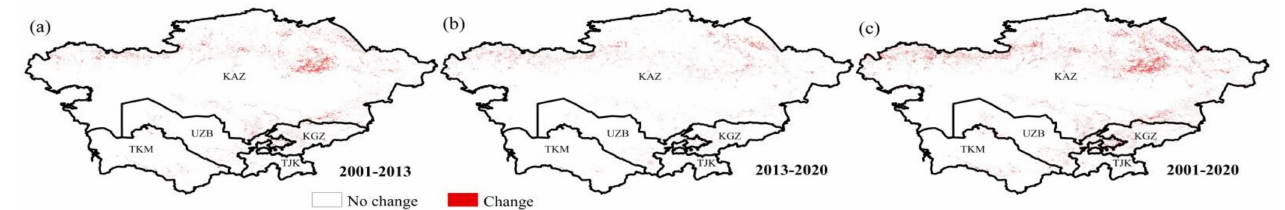
Figure 4. Spatial distribution of LUCC in the CANs from 2001 to 2013 ( a ), 2013–2020 ( b ) and 2001–2020 ( c ).